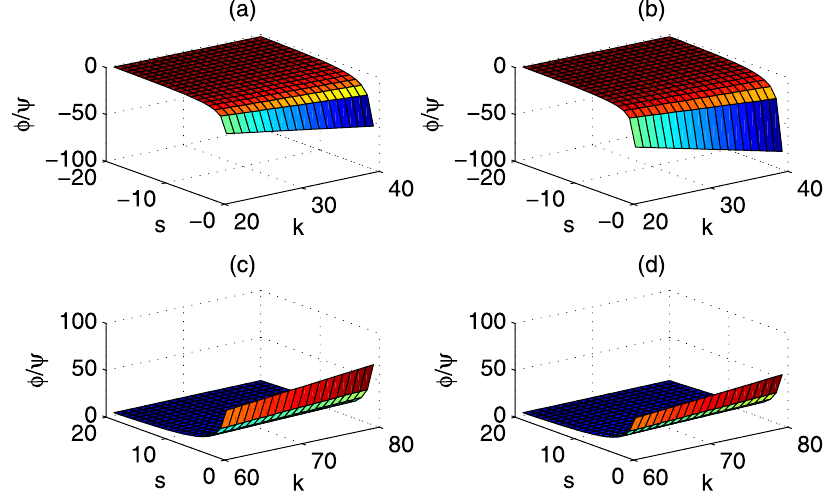
Figure 7. The phase ratio φ ψ µ χ = t t / ( )/( ) for the iSWAP gate and the inverse of iSWAP. ( a , b ) Denote the evolution times using the first set of parameters shown in Fig. 4(a). ( c , d ) Denote the evolution times using the second set of parameters shown in Fig. 4(c).